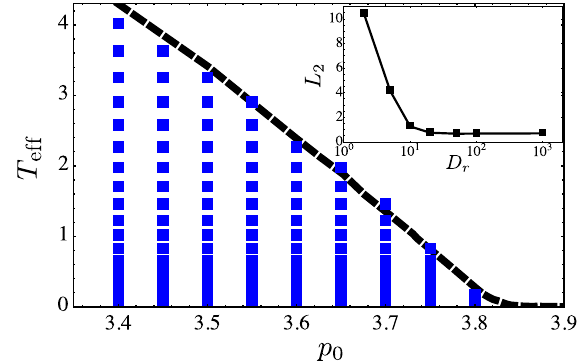
FIG. 5. ComparisonbetweenSPVglasstransitionandananalytic prediction based on a soft glass rheology (SGR) continuum model. The dashed line corresponds to a SGR prediction with no fit parameter based on previously measured vertex model trap depths 10 − 3 [27]. Data points correspond to SPV simulations with D r ¼ cv 2 0 with c ¼ 0 . 1 as the best-fit and where we define T eff ¼ normalization parameter. Blue points correspond to simulations < 10 − 3 , and the boundary of these that are solidlike, with D eff points defines the observed SPV glass transition line. Inset: L 2 difference between SPV glass transition line (at best-fit value of c ) and the predicted SGR transition line at various values of D . The r SGRpredictionbasedonlocalized T 1 trapdepthsworkswellinthe high D limit, but not in the low D r r